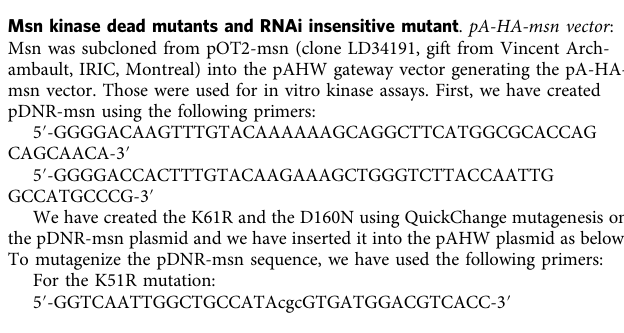
Fig. 6 Msn is required for border cell contractility. a Schematic representation explaining how the morphodynamic analysis of migrating clusters was performed using the ADAPT plugin of ImageJ. The plugin measures the displacement of the overall cluster according to its geometric center (orange dotted circle) and represents these quanti fi cations as a color-coded kymograph. On thes schemes, negative velocities/retraction events are represented by blue arrows whereas positive velocities/extensions events are represented by red arrows. b Morphodynamic map displays as a kymograph the segmental velocities calculated and color-coded for visualization, for each position of the periphery of a cluster (red colors, extension; blue colors, contraction). The center of the MDM depicts the dynamics at the front of the cluster (purple) while the side (light blue) and the back (green) of the cluster is split at both the top and bottom extremities of the MDM. c Velocities measured at each time point of the corresponding morphodynamic map shown in b (left, control cluster, right, Msn-depleted cluster). d Mean velocity values over time for extensions (red) and contractions (blue) in control ( fi lled line, n = 7 independent BC clusters) and Msn-depleted clusters (dotted line with circles, n = 8 independent BC clusters). e Dot plot of each velocity values for each times point for each movies (for extensions and contractions) *** p < 0,001, two ways ANOVA test. Error bars show s.e.m. f Histogram representing the mean variance for extensions and contractions velocities. Unpaired Student ’ s t -test, ** p < 0.01. Error bars show s.e.m. ( n = 7 independent Control clusters and n =